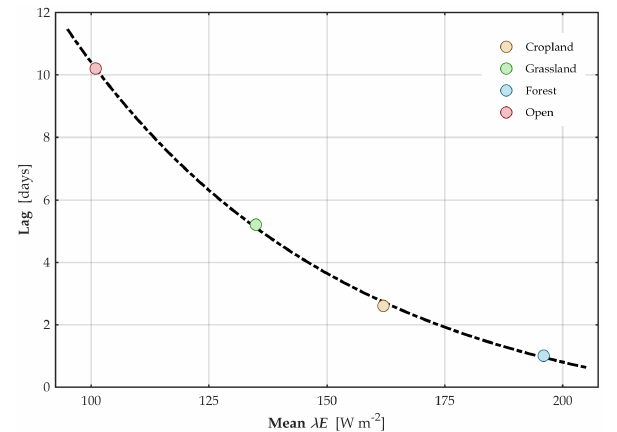
Figure 4. The maximum lag where the autocorrelation function ex- ceeds 0.50 plotted as a function of the mean daytime latent heat flux is